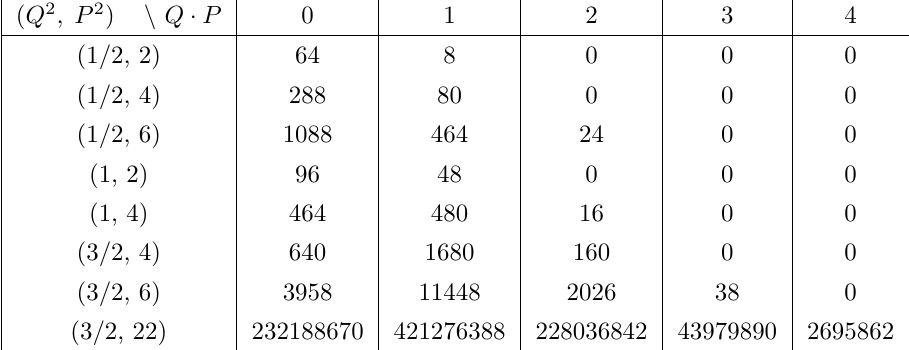
Table 6 . Index of horizon states for the 3 A orbifold of K 3 .